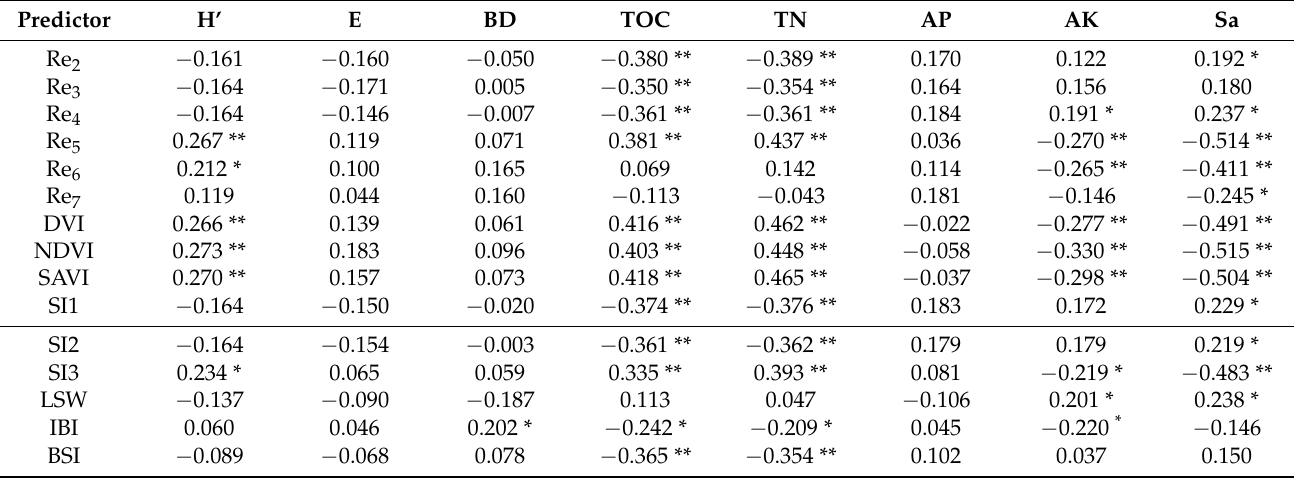
Table 1. Correlations of the simulated point factors with the